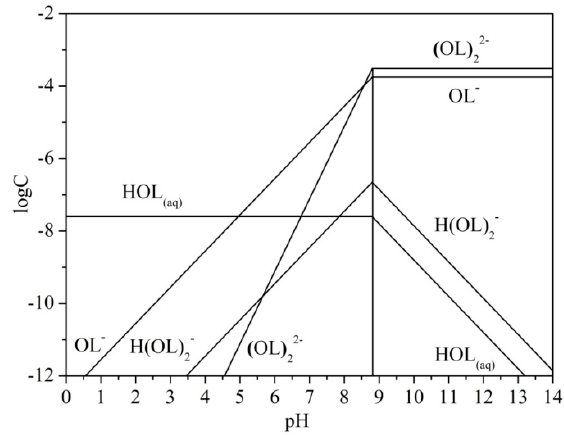
Figure 4. Logarithmic concentration of the hydrolysis species at an initial sodium oleate concentration of 8.0 × 10 − 4 mol·L − 1 .